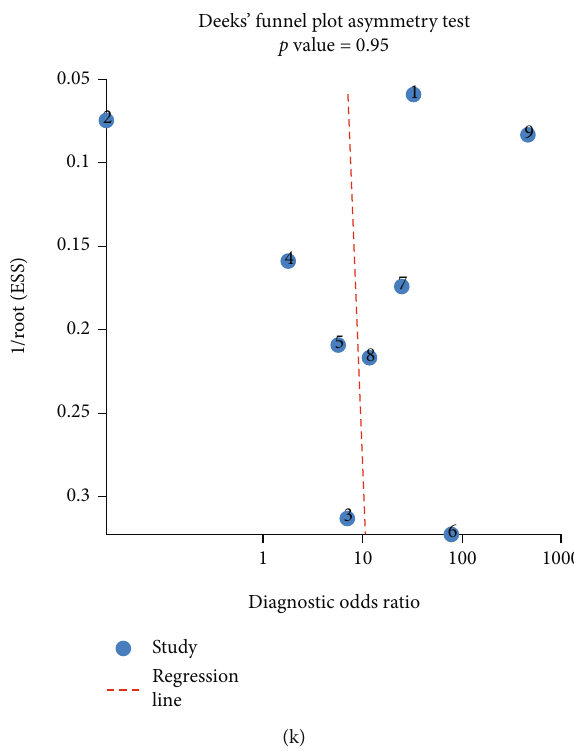
Figure 3: The receiver operating characteristic (ROC, (a) – (i)) and sROC (j) curves of CCDC80 in OVCA and Deek ’ s test for publication bias test